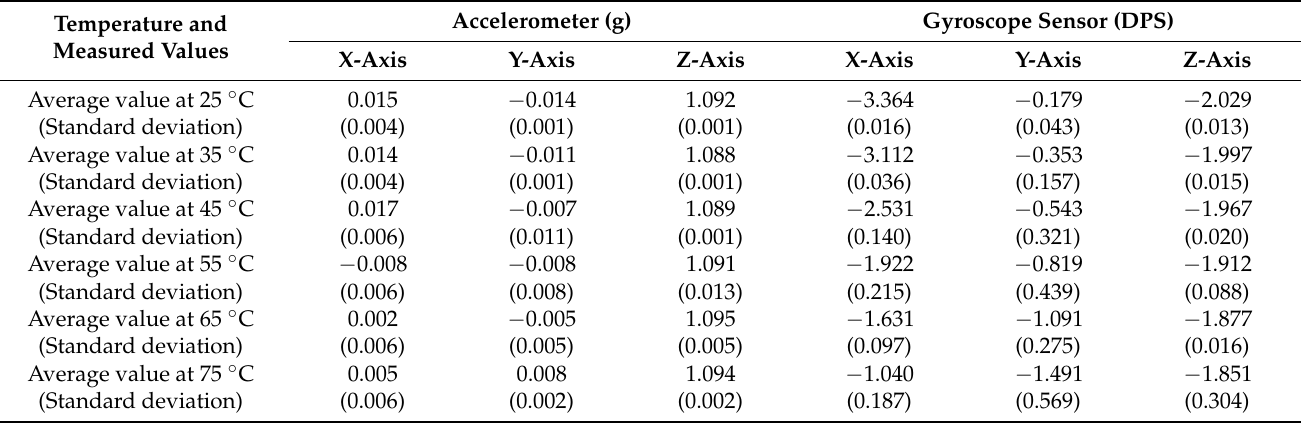
Table 1. Experimental results of measurement